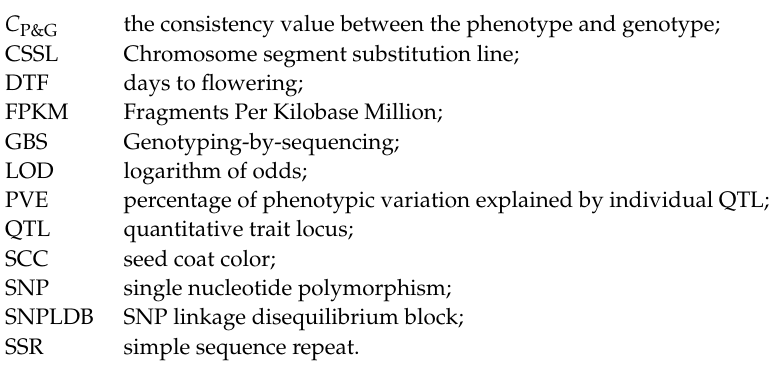
Table S2. Summary of the sequencing data of SojaCSSLP5 along with its two parents. Table S3. Summary of SNPs identified in parents and SojaCSSLP5. Table S4. Descriptive statistics of the DTF in the three environments Table S5. Joint analysis of variance of days to flowering in SojaCSSLP5. Table S6. The expression of genes associated with seed coat color and days to flowering. Table S7. The allelic variations of candidate genes between N24852 and